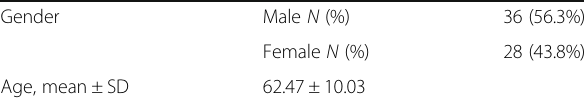
Table 3 Mean value of common carotid artery intimal medial thickness